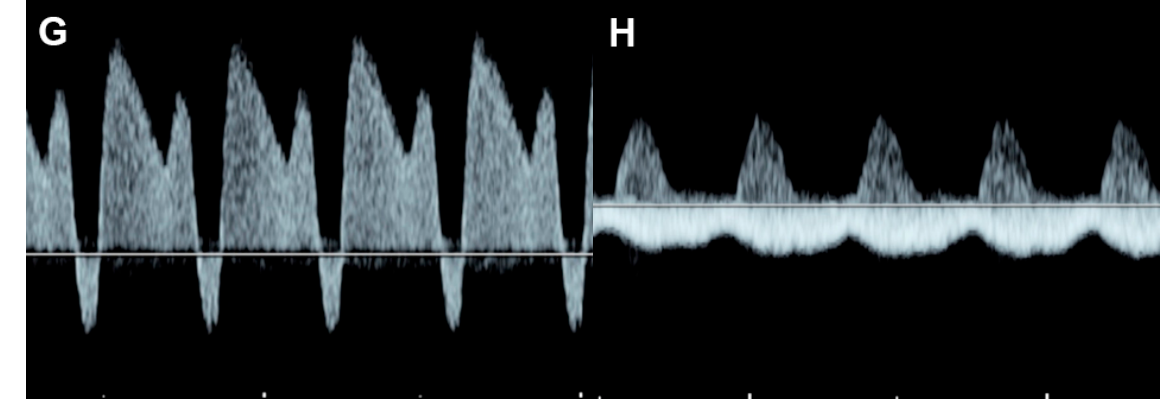
Figure 7. Fetal growth restriction: ( A – C ) Progressive changes of Doppler waveforms of the umbilical artery from low-end-diastolic flow at 27 weeks, to absent end-diastolic flow ( B ), and reversed end-diastolic flow ( C ) at 32 weeks; ( D ) Increased end-diastolic flow in the middle-cerebral artery (cephalization); ( E ) increased Tei index (0.61) with prolonged IRT (0.52 ms); ( F ) shortening fraction of 25%. ( G ) reversed A-wave in the ductus arteriosus; ( H ) pulsations in the umbilical vein at 32 weeks.